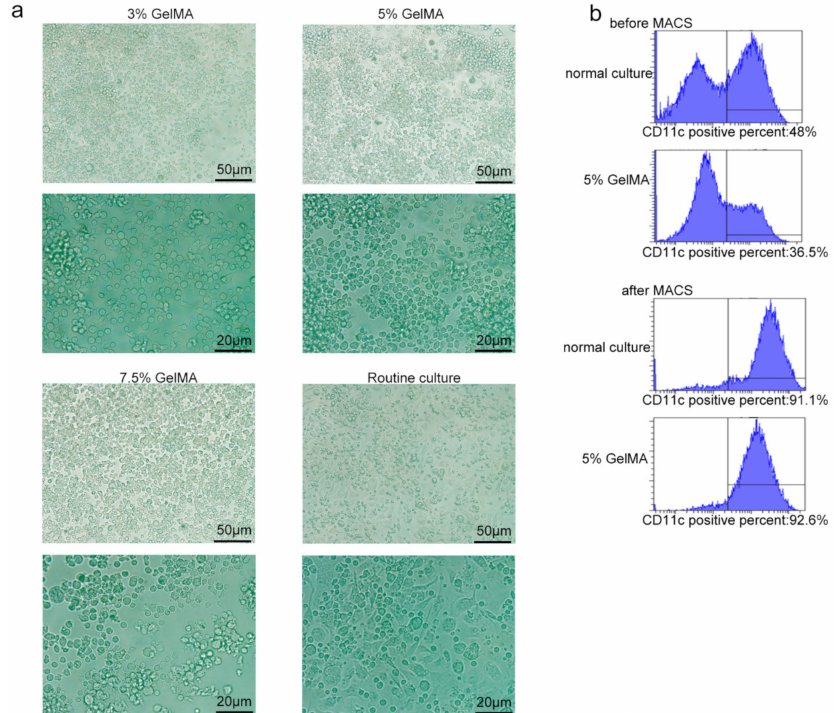
Figure 2. BMDCs on GelMA-30 with the morphology of fewer tentacles. ( a ) BMDCs by CCHS (3%, 5% and 7.5% GelMA-30) or on normal condition, respectively, were collected the seventh day